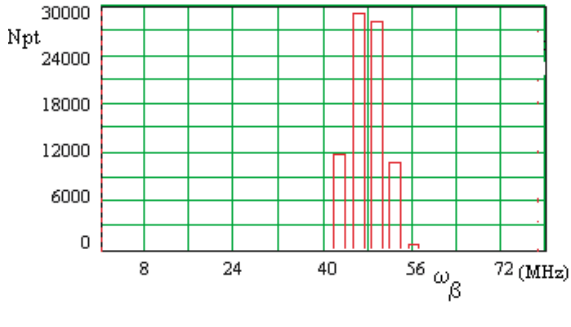
FIG. 3. (Color) The rms envelope oscillations with initial Gauss- ian distribution for s (cid:5) s 0 (cid:2) 0.55 . The black line refers to the odd mode and the magenta line to the even mode.